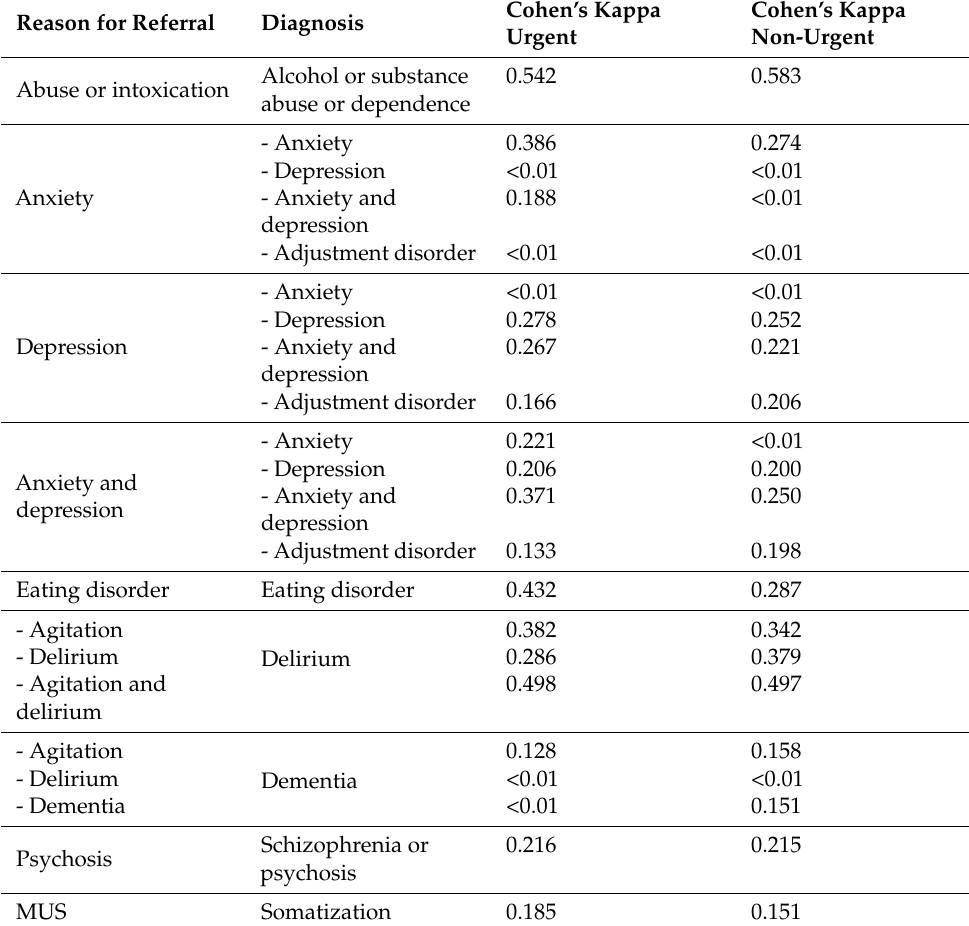
Table 4. Comparison of inter-rater agreements: Urgent vs. non-urgent